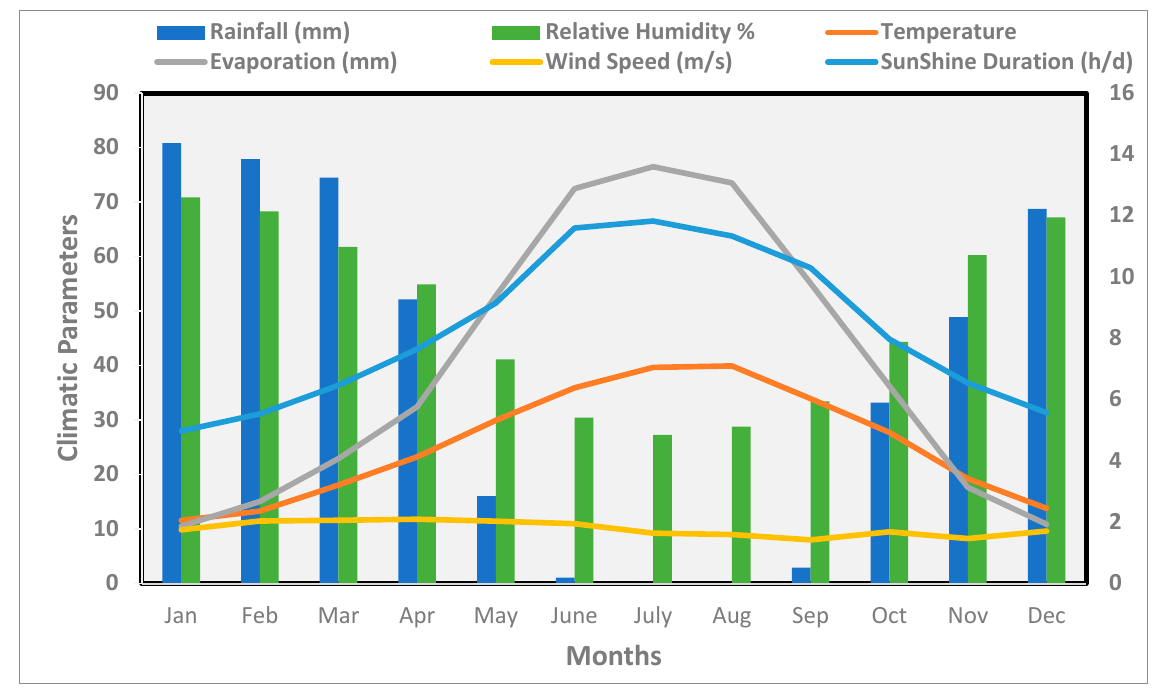
Figure 2. Mean monthly climatic parameters in the study area for the period 2003–2020 .